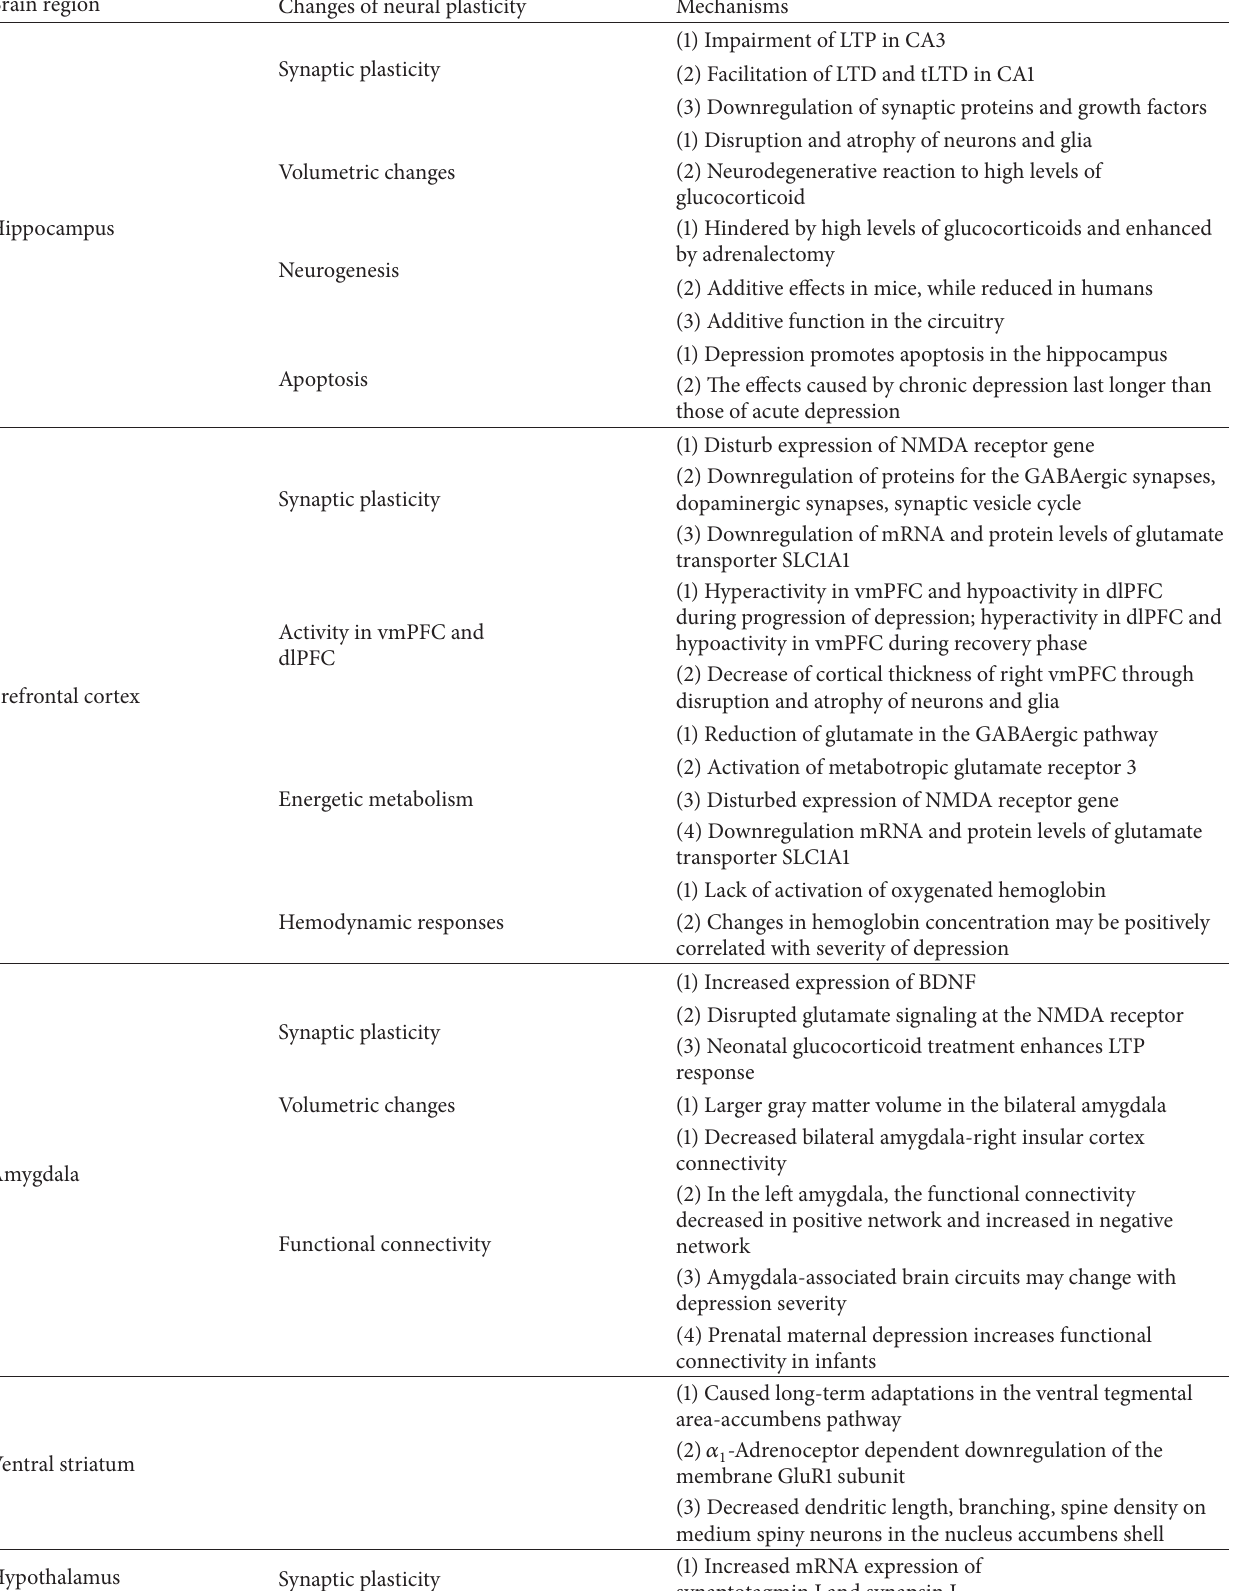
Table 1: Changes of neural plasticity induced by depression in various brain